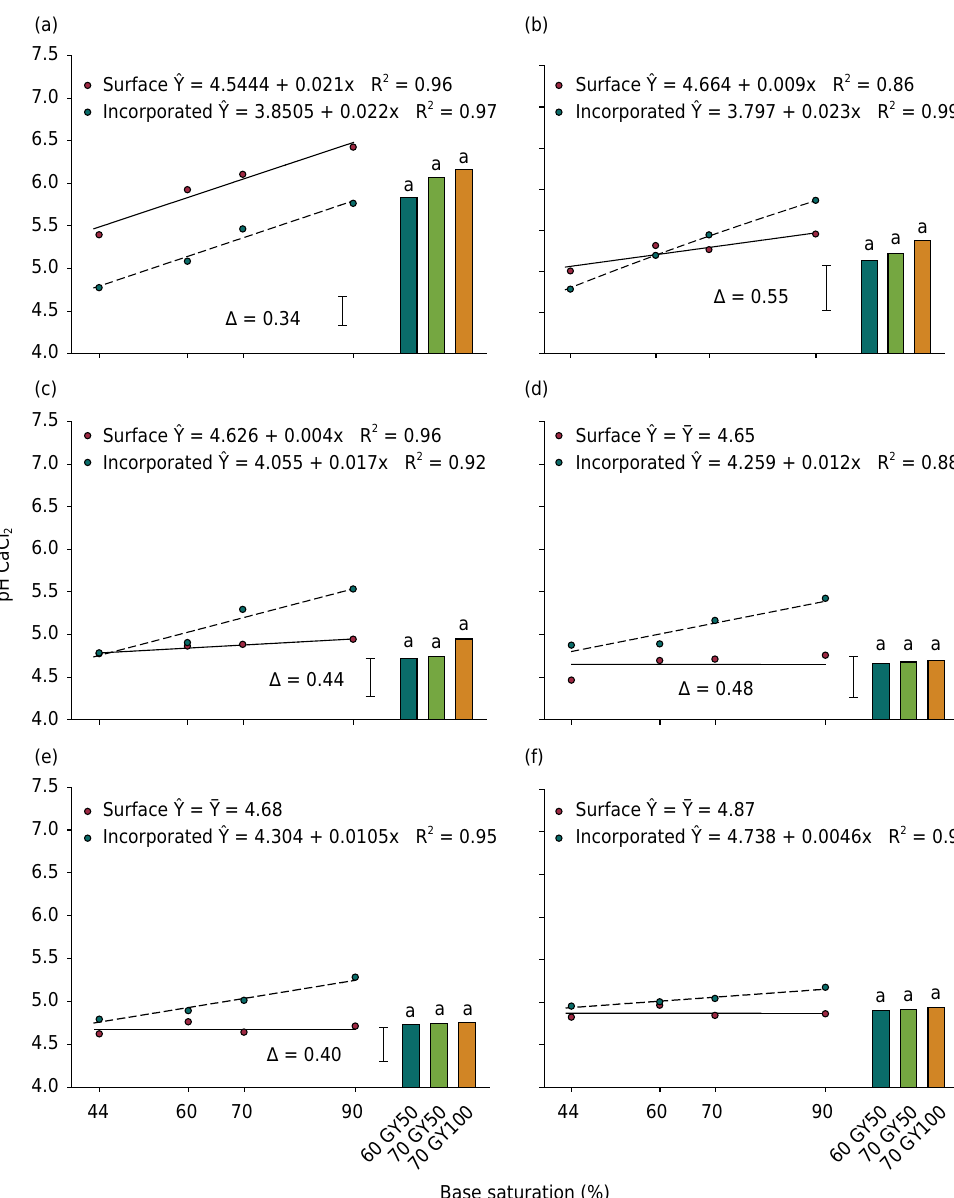
Figure 1. Soil pH after reapplication of lime and phosphogypsum at different layers (m): 0.00-0.05 (a), 0.05-0.10 (b), 0.10-0.20 (c), 0.20-0.30 (d), 0.30-0.40 (e), and 0.40-0.60 (f). Different letters above the bars indicate a significant difference between the treatments with phosphogypsum based on Tukey’s test (p<0.05). The vertical bar indicates the DMS between each factorial vs additional treatment based on a Dunnett test (p<0.05). An F test revealed a significant difference between the modes of lime application to the layers presented in figures 1a (p<0.00), 1b (p<0.00), 1c (p<0.02), and 1d